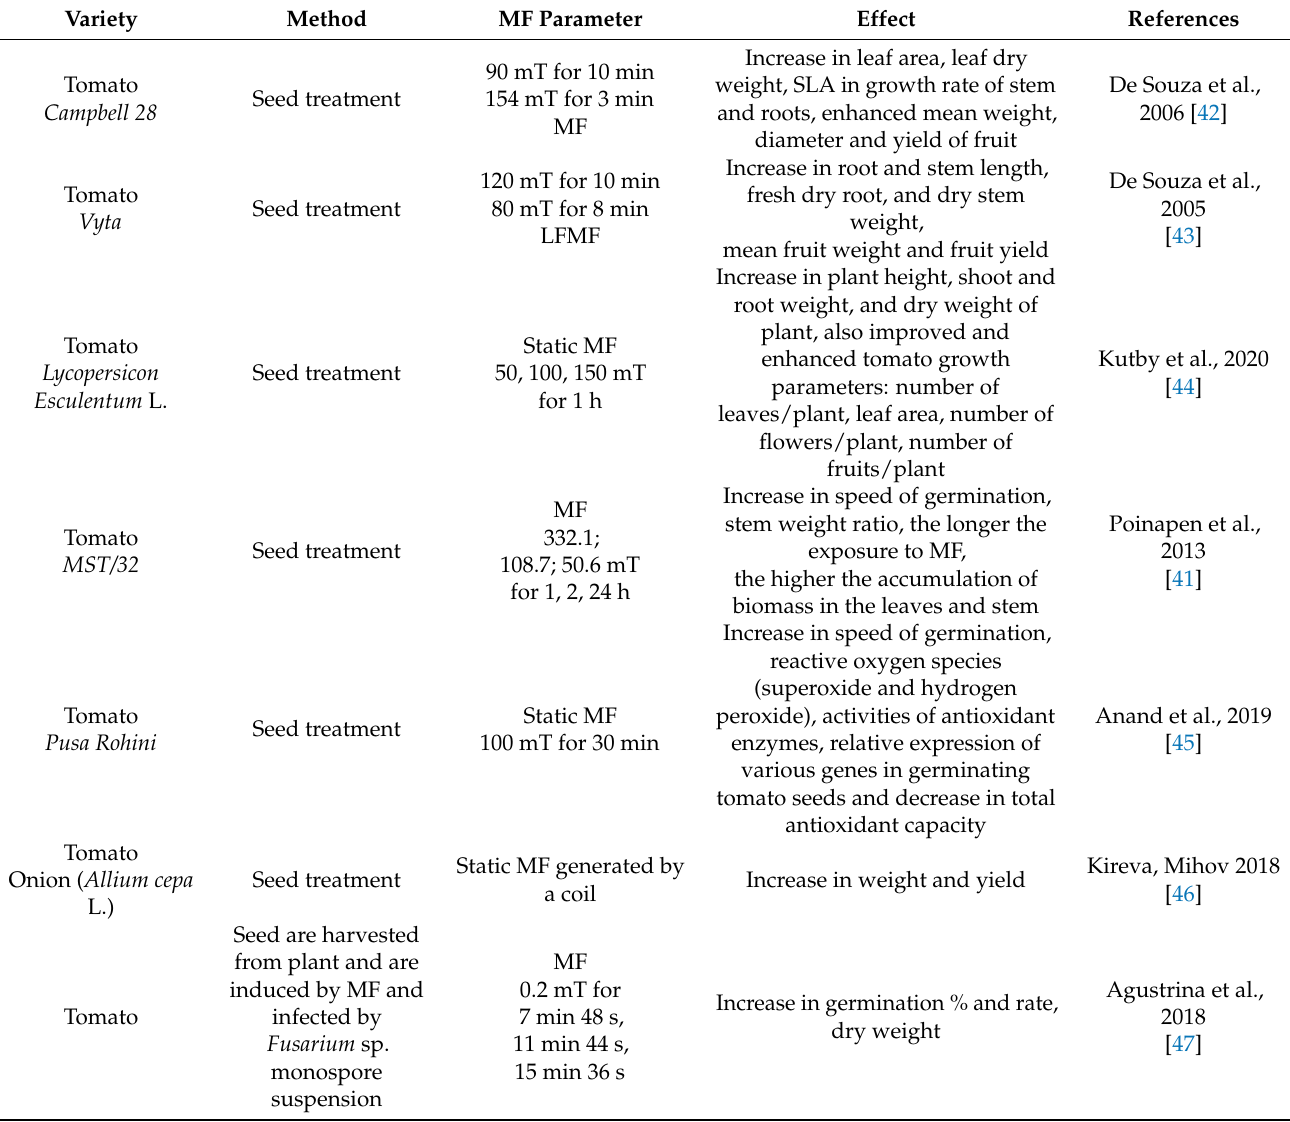
Table 1. Summary of the total effect of magnetic fields on the yield and growth of